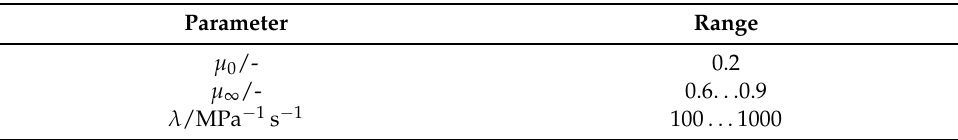
Table 5. Representation of the reasonable ranges for the parameters freely selectable in the model on the investigated asphalt